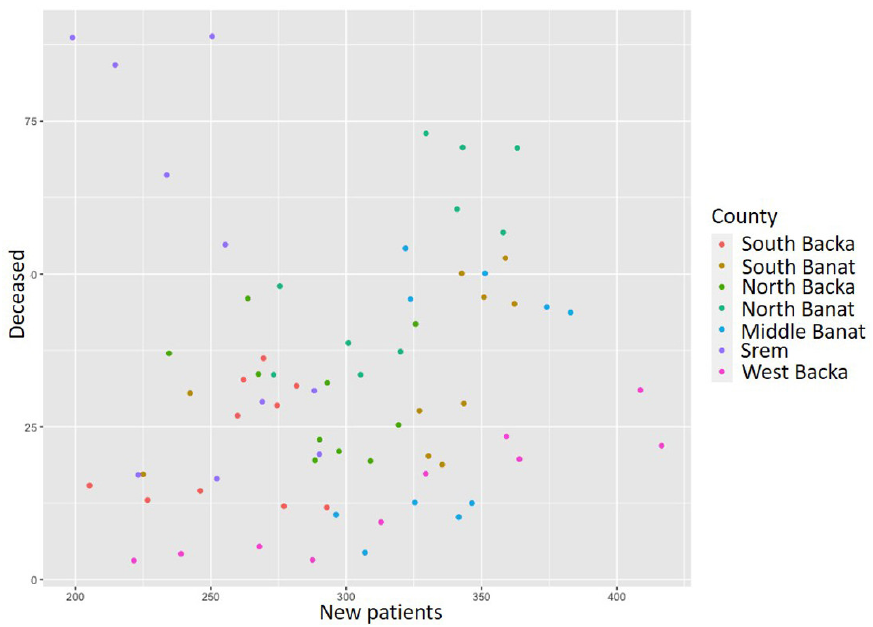
Figure 16. Diabetes incidence and mortality rate ratio per 100,000 population from 2010 to 2019.